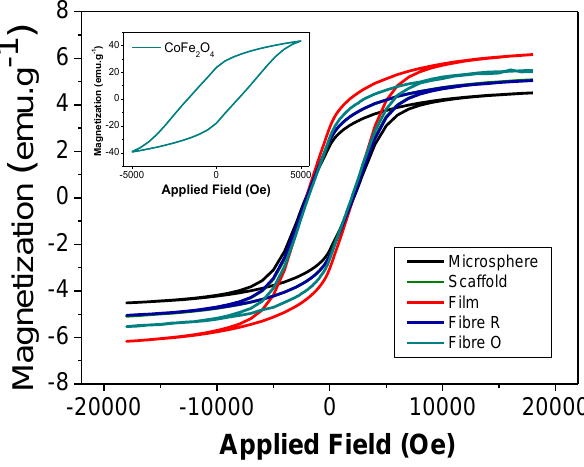
Figure 5. Room temperature hysteresis curves for the CFO/PHBV composites.